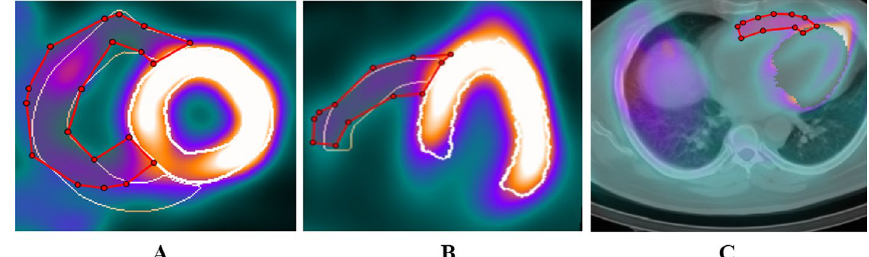
B views. C The fused SPECT-CT image with the physician’s contour in